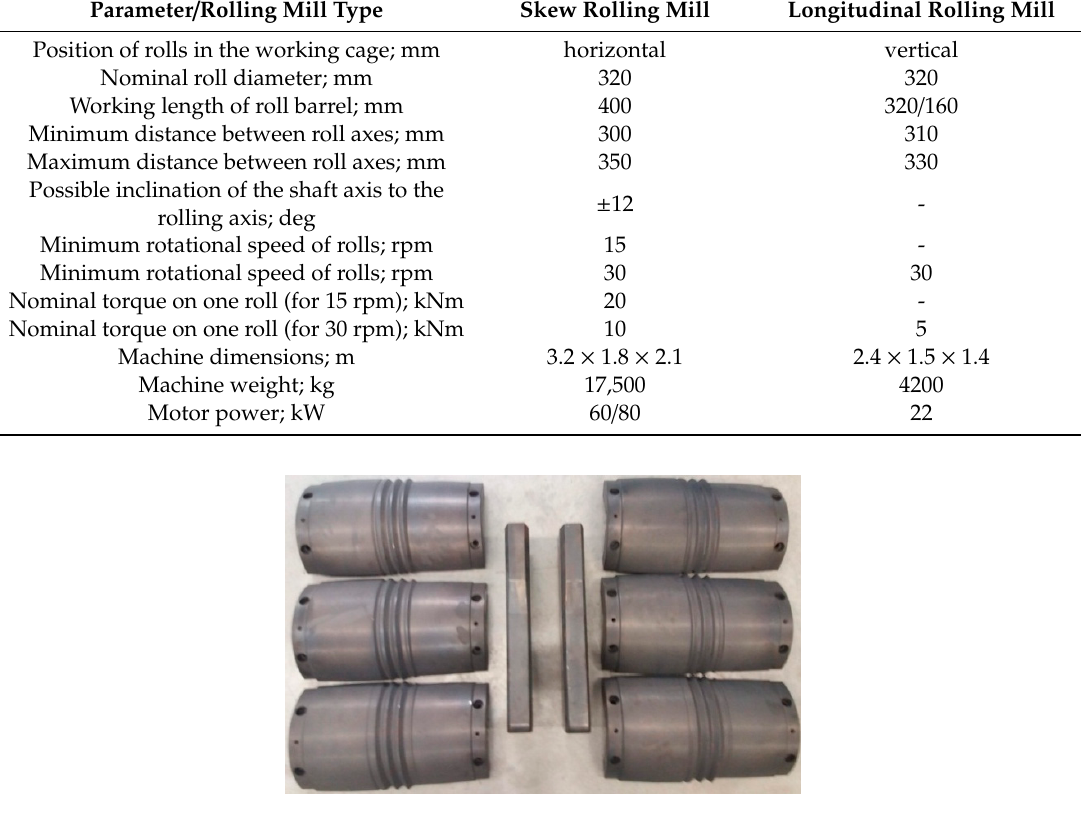
( c ) Figure 14. The sequential stages of rolling of rods from scrap rail heads: ( a ) rolling of the preform in the longitudinal mill; ( b ) feeding of the rolled preform to the skew mill; ( c ) a rod rolled in a helical pass, leaving the work space of the skew mill.